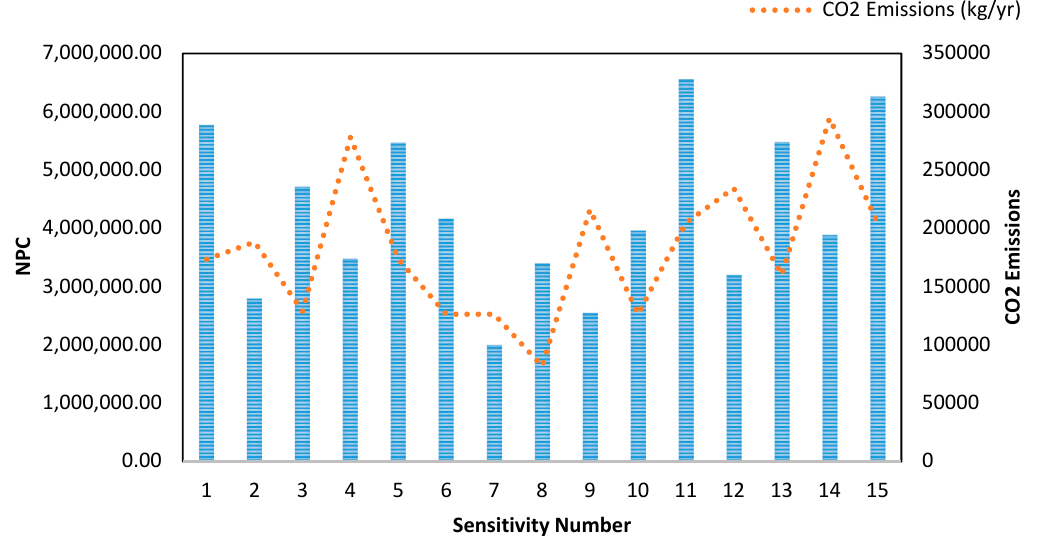
Figure 14. NPC and CO 2 emissions for all the different cases.